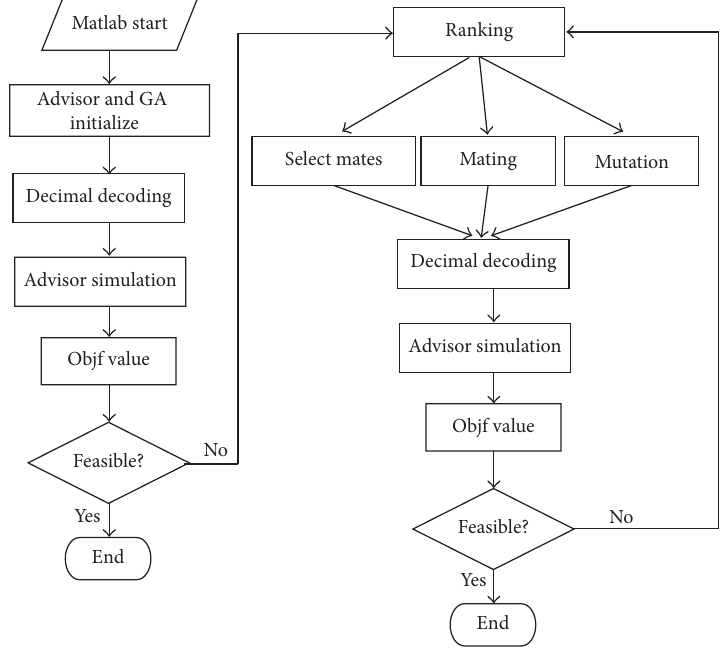
Figure 2: Flowchart for combination simulation.